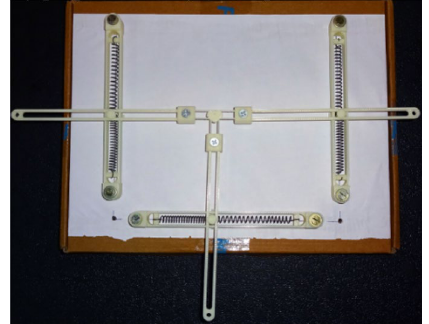
Fig. 7 Assembled C10 configured